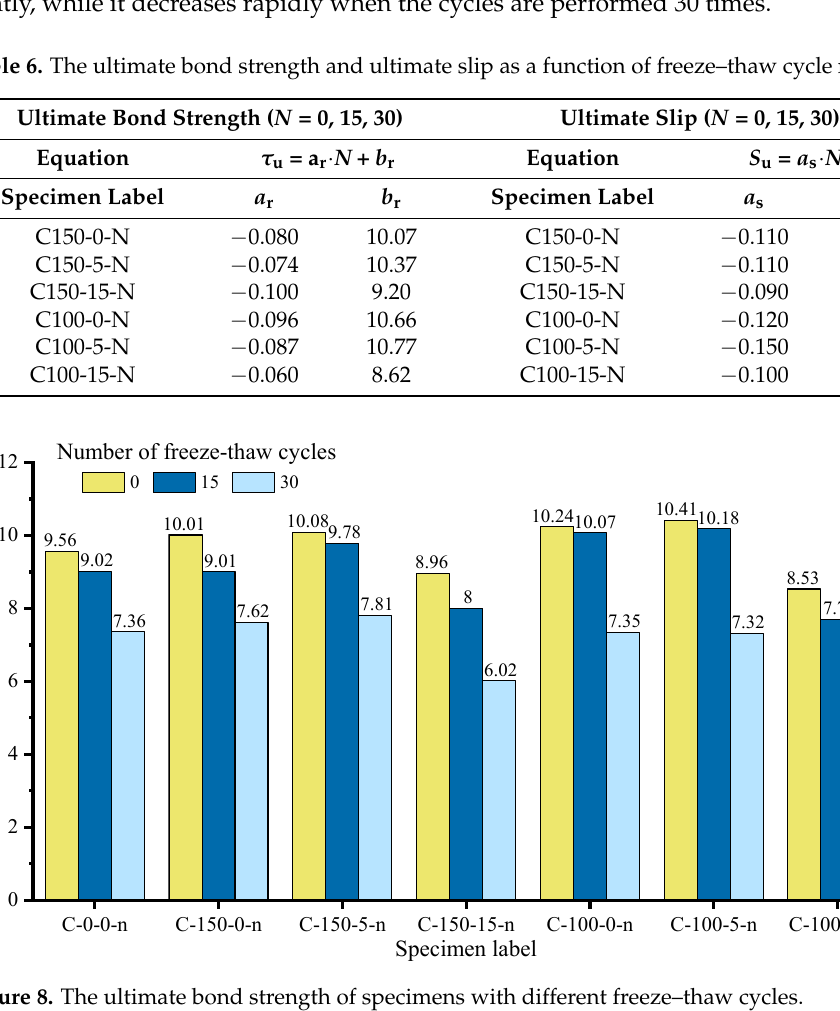
Figure 8. The ultimate bond strength of specimens with different freeze–thaw cycles.